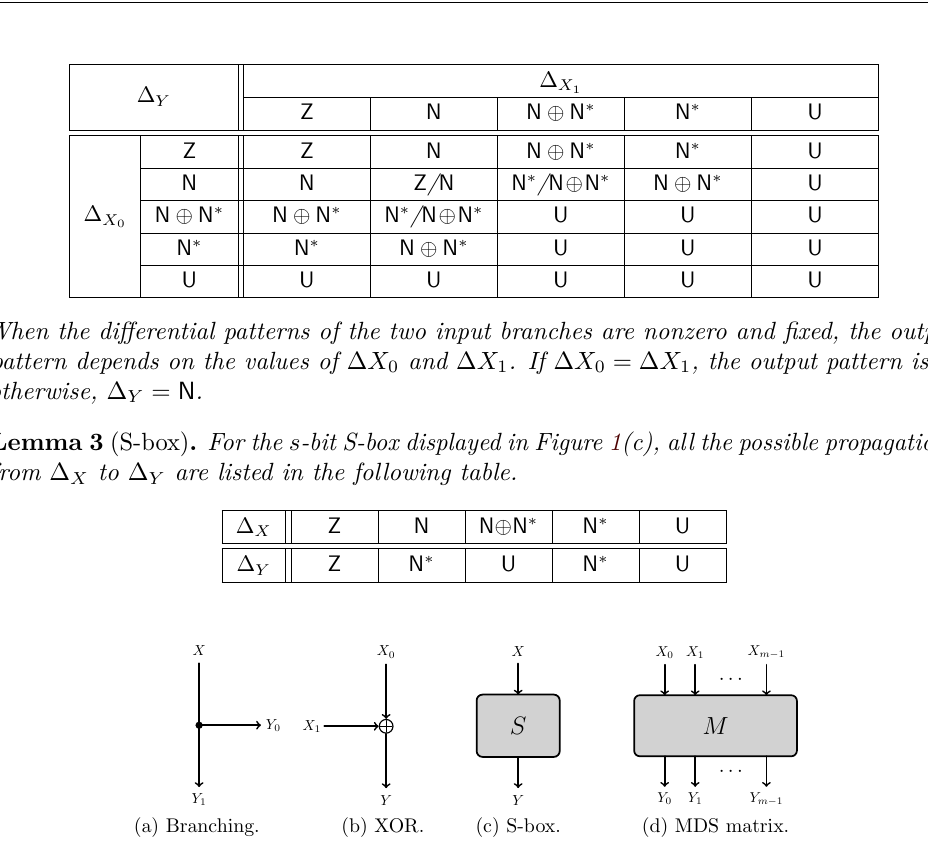
Figure 1: Frequently-used